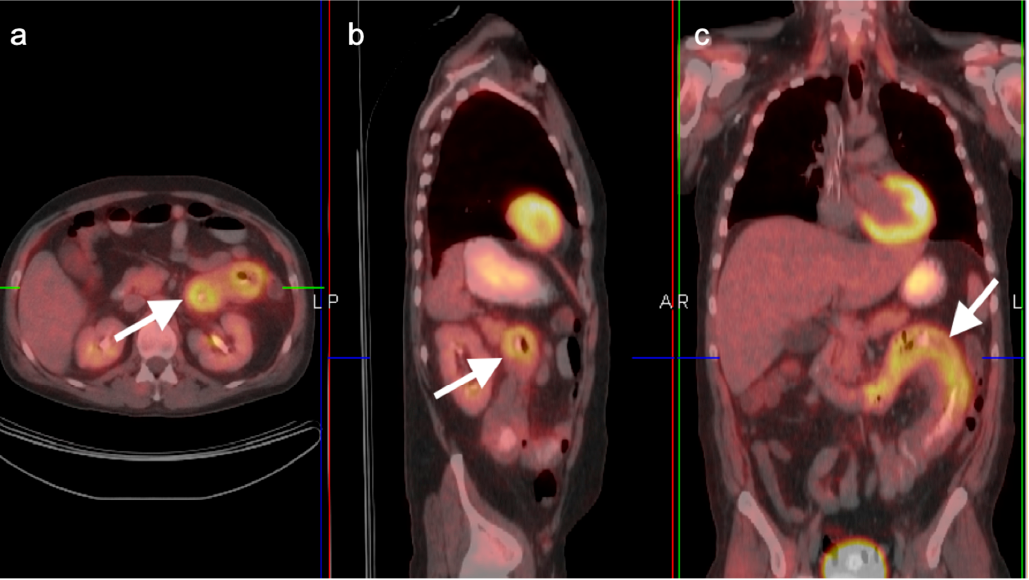
Figure 35. Typhlitis. Fused FDG PET-CT images in axial ( a ), sagittal ( b ) and coronal ( c ) planes. In this neutropenic patient, segmental bowel wall thickening and increased metabolic activity in the distal duodenum/proximal jejunum (white arrows) is typical in appearance for typhlitis, although a more common location is terminal ileum.